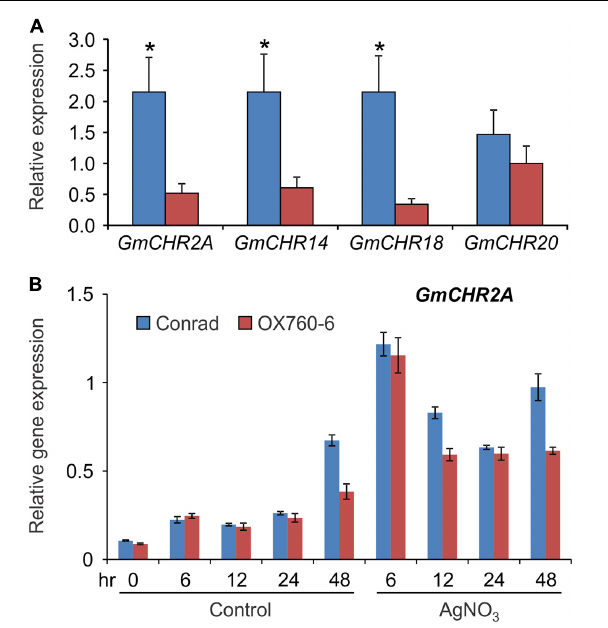
FIGURE 7 | Accumulation of root-specific GmCHR s in Conrad and OX760-6. Total RNA (1 µ g) was used to synthesize cDNA from (A) roots, and (B) untreated and AgNO3-treated etiolated hypocotyls of soybean cv. Conrad and OX760-6. Expression analysis was conducted by qPCR using gene-specific primers. Error bars indicates SEM of three technical replicates per biological replicates where 2 biological replicates for roots and 4 biological replicates for etiolated hypocotyls were used. CONS4 was used as a reference gene. The asterisks ( ∗ ) denotes significant difference in expression as determined by Student’s t -test ( p <